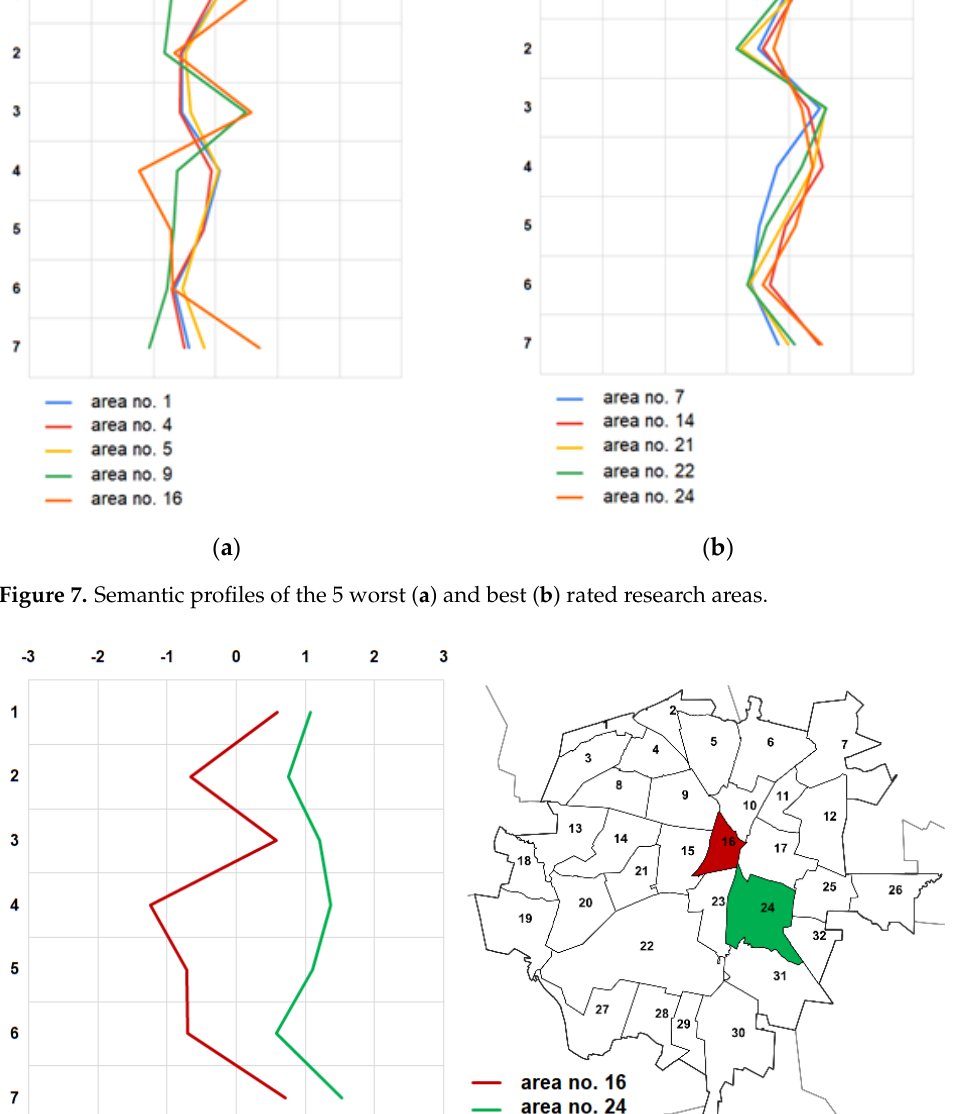
Figure 8. Semantic profiles of areas selected for detailed analyses: area no. 16 (red) rated as one of the worst; area no. 24 (green) rated as one of the best.